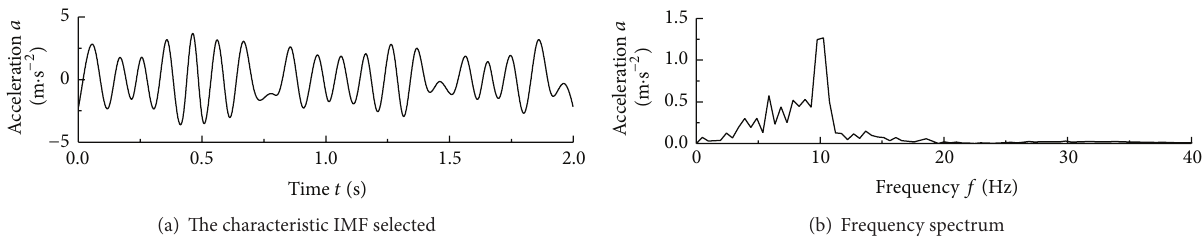
Figure 14: Analysis results of the signal presented in Figure 13 by improved EMD: (a) the characteristic IMF and (b) FFT spectrum.